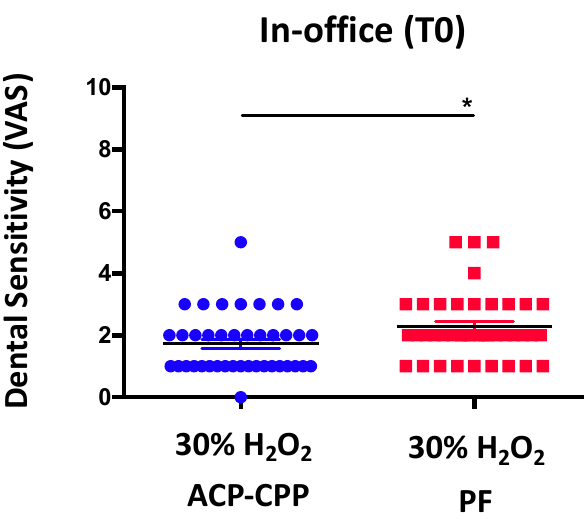
Figure 1. Effects of ACP-CPP combination on dental sensitivity, following in-office oral hygiene procedures. ACP-CPP treatment significantly reduced dental sensitivity, as compared to the control group (PF), immediately after treatment (T1). Results are showed as mean ± SEM, * p ≤ 0.05 .